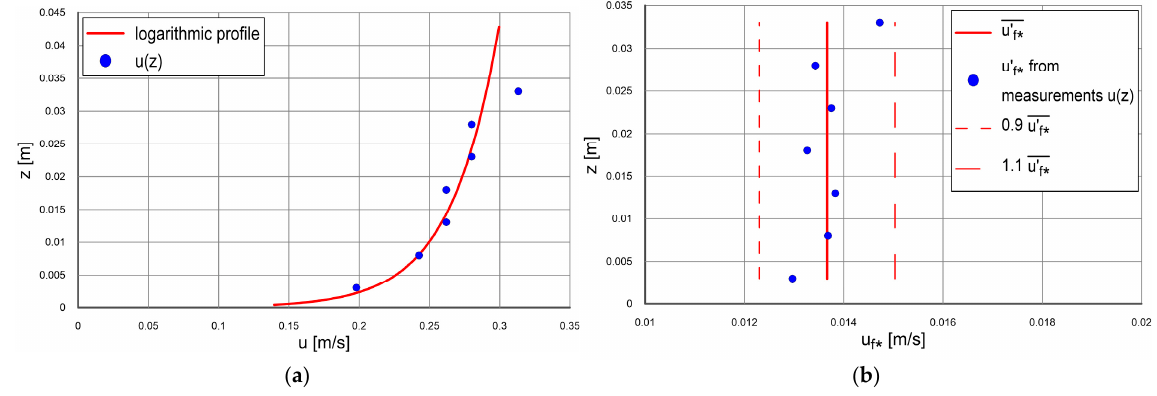
Figure 5. Exemplary vertical profile: ( a ) vertical velocity profile for the measured 𝑢(𝑧) and the log- arithmic profile with the depth average shear velocity 𝑢 (cid:3033)∗(cid:4593) (cid:3364)(cid:3364)(cid:3364)(cid:3364) ; ( b ) the shear velocities taken from 𝑢(𝑧) measurements in comparison with the dept average value 𝑢 (cid:3033)∗(cid:4593) (cid:3364)(cid:3364)(cid:3364)(cid:3364) . logarithmic profile with the depth average shear velocity u measurements in comparison with the dept average value u (cid:48)